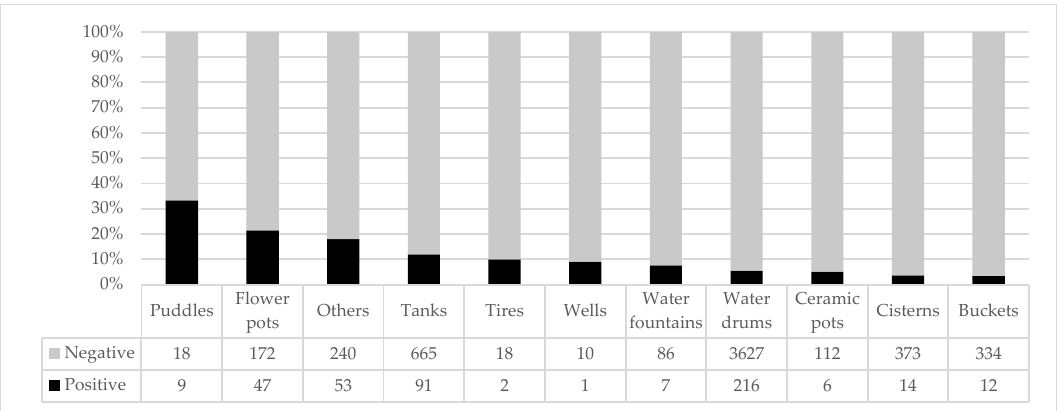
Figure 2. Number and proportion of positive and negative breeding sites inspected during the study.